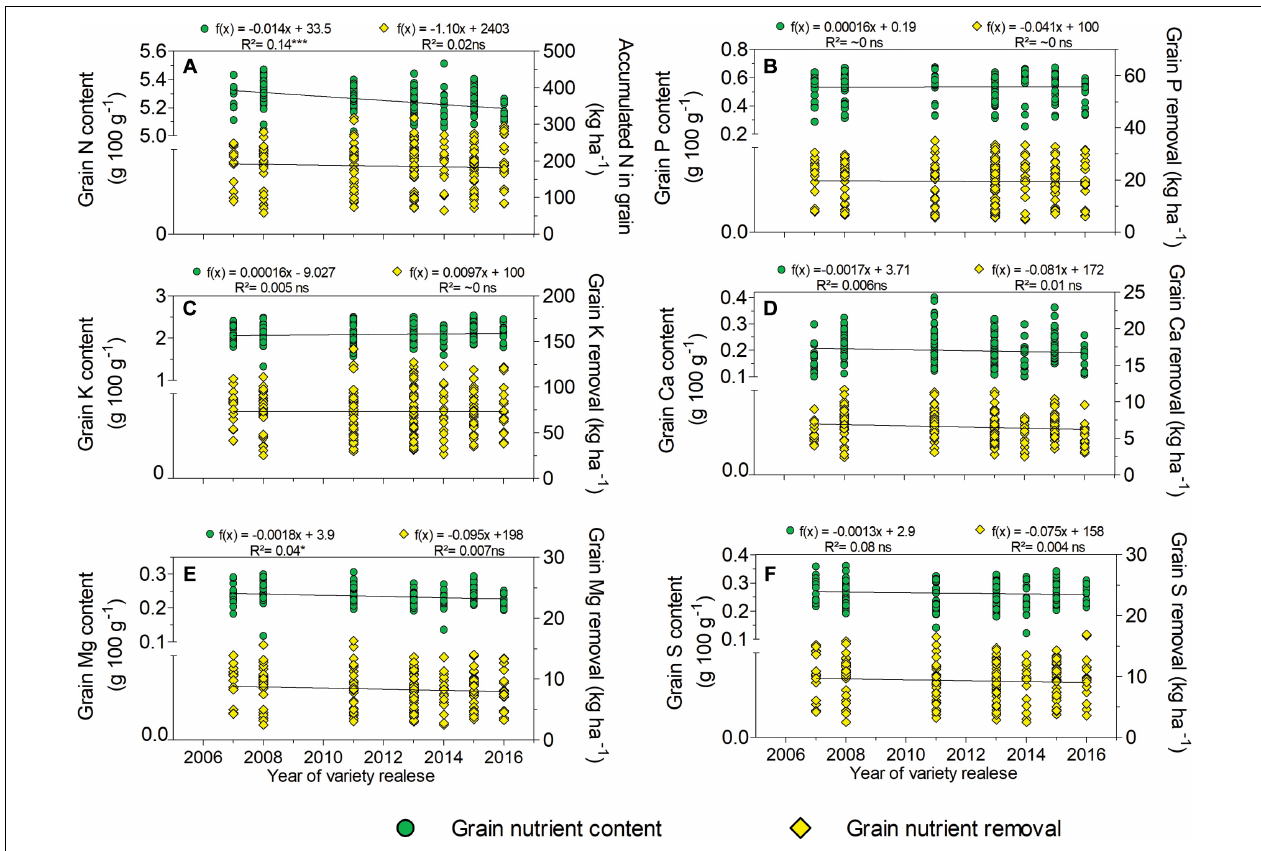
FIGURE 2 | Relationship between the years of varieties’ releases and grain nutrient content of soybean or amount of nutrient removal in the current study ( n = 192): (A) nitrogen, (B) phosphorus, (C) potassium, (D) calcium, (E) magnesium, and (F) sulfur. ns = not significant. *Significant at 5% and ***significant at <